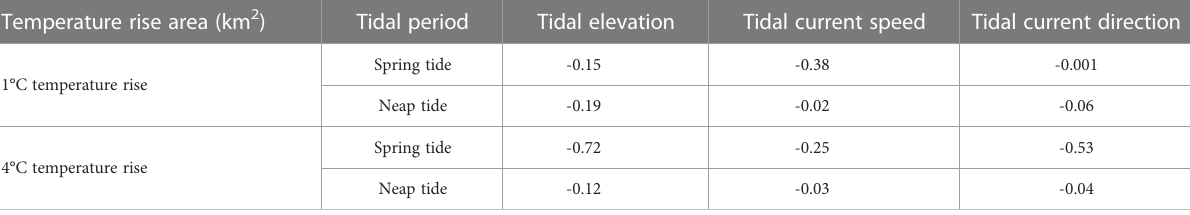
TABLE 2 Correlation coef fi cients between the temperature rise (1°C and 4°C) envelope area and tidal elevation, tidal current during spring and neap tide periods. Temperature rise area (km 2